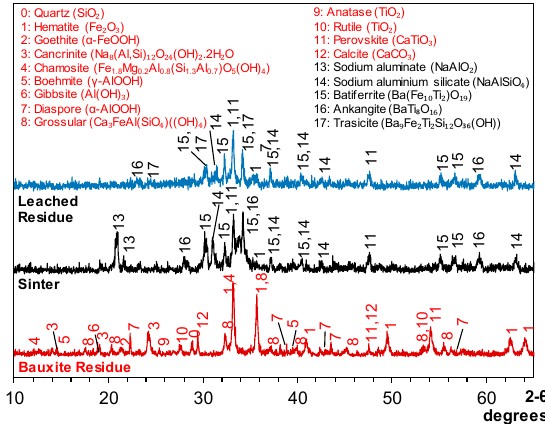
Figure 19. XRD of mineralogical phases for BaO additions (20 g BaO/100 g bauxite residue) at atmospheric conditions at 900 °C and for 2 h. Red font: Existing minerals in bauxite residue; black font: Transformed sinter and leached minerals